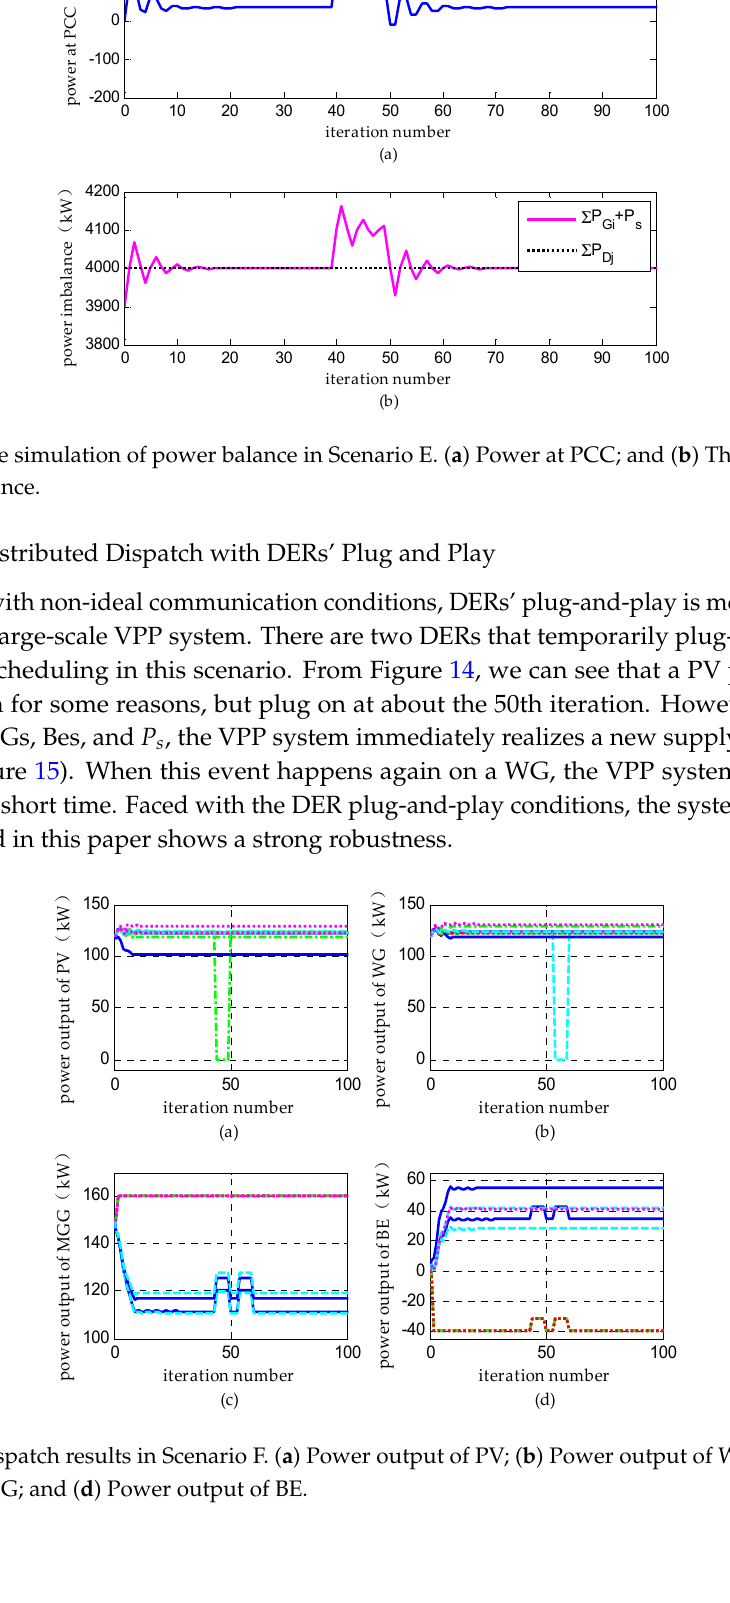
Figure 12. Dispatch results in Scenario E . ( a ) Power output of PV; ( b ) Power output of WG; ( c ) Power output of MGG; and ( d ) Power output of BE.